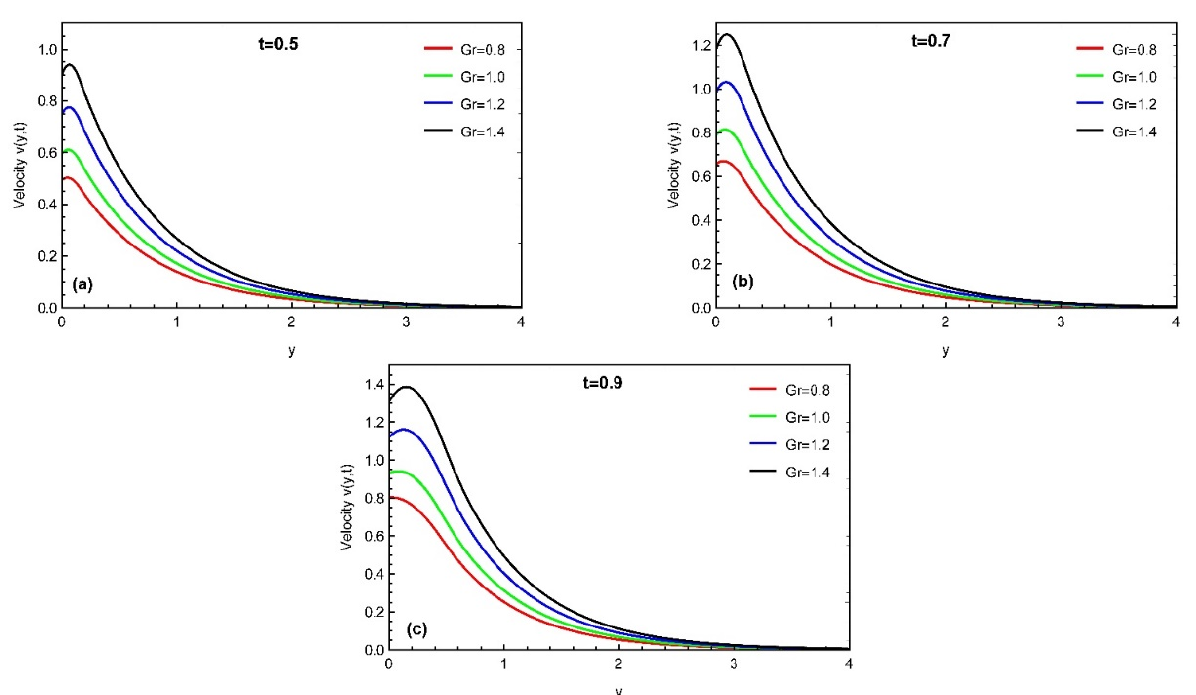
Figure 8. Variation in momentum field due to heat Grashof number with 𝛼 = 𝛽 = 𝛾 = 0.7, 𝑃𝑟 (cid:3032)(cid:3033)(cid:3033) = 1.4, 𝑆𝑐 (cid:3032)(cid:3033)(cid:3033) = 1.1, 𝑀 = 1.75, 𝐺𝑚 = 0.5, 𝑅𝑒 = 1.3, 𝜃 (cid:2869) = 𝜃 (cid:2870) = (cid:3095) 0.5 ( b ) 𝑡 = 0.7 ( c ) 𝑡 = 0.9 .